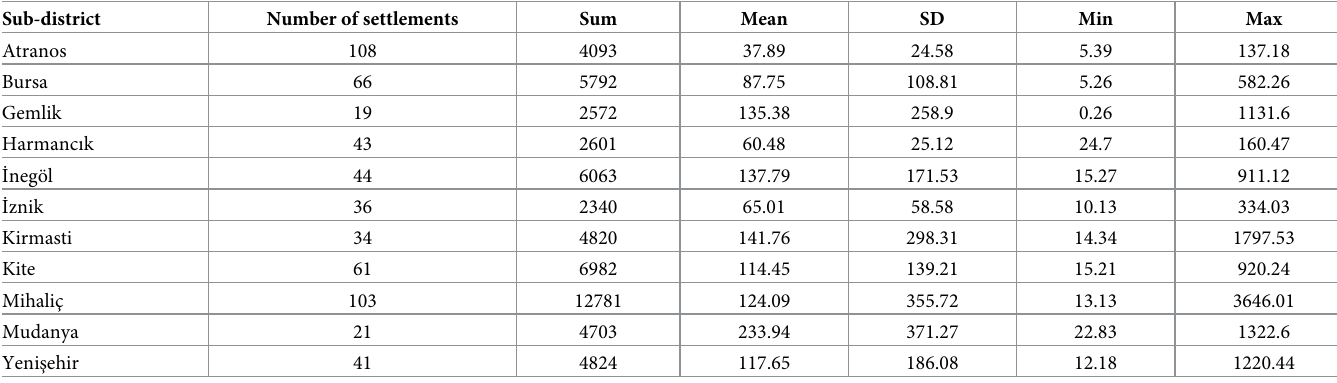
Table 8. Summary statistics of estimated and observed agricultural production (in tonne) from Model 2.